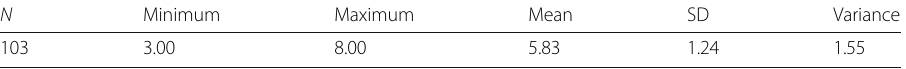
Table 4 Descriptive statistics of teachers ’ assessment of sample letter writing